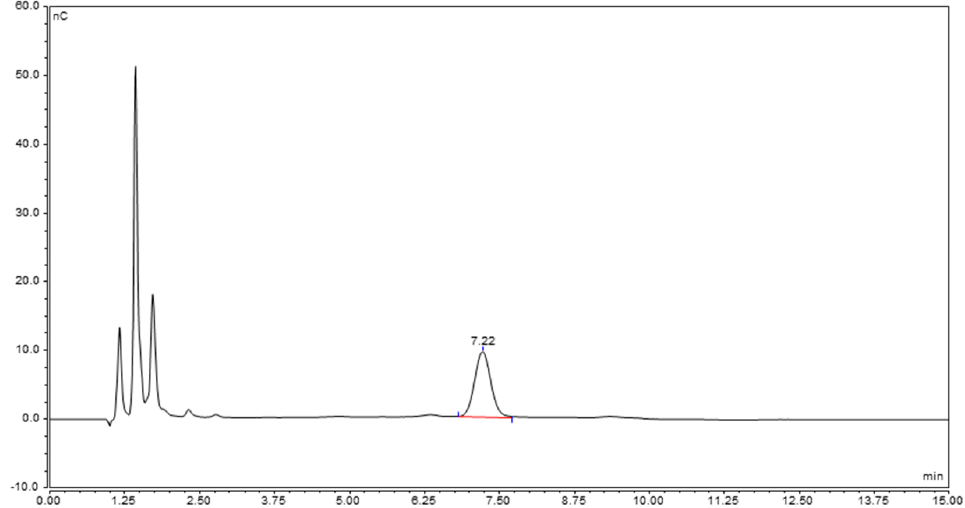
Figure 4. HPAEC-PAD chromatogram of the dimer GalA-GalN obtained after hydrolysis of S. flexneri 6 OAg, eluted in CarboPac PA1 column with NaOH 400 mM as eluent.